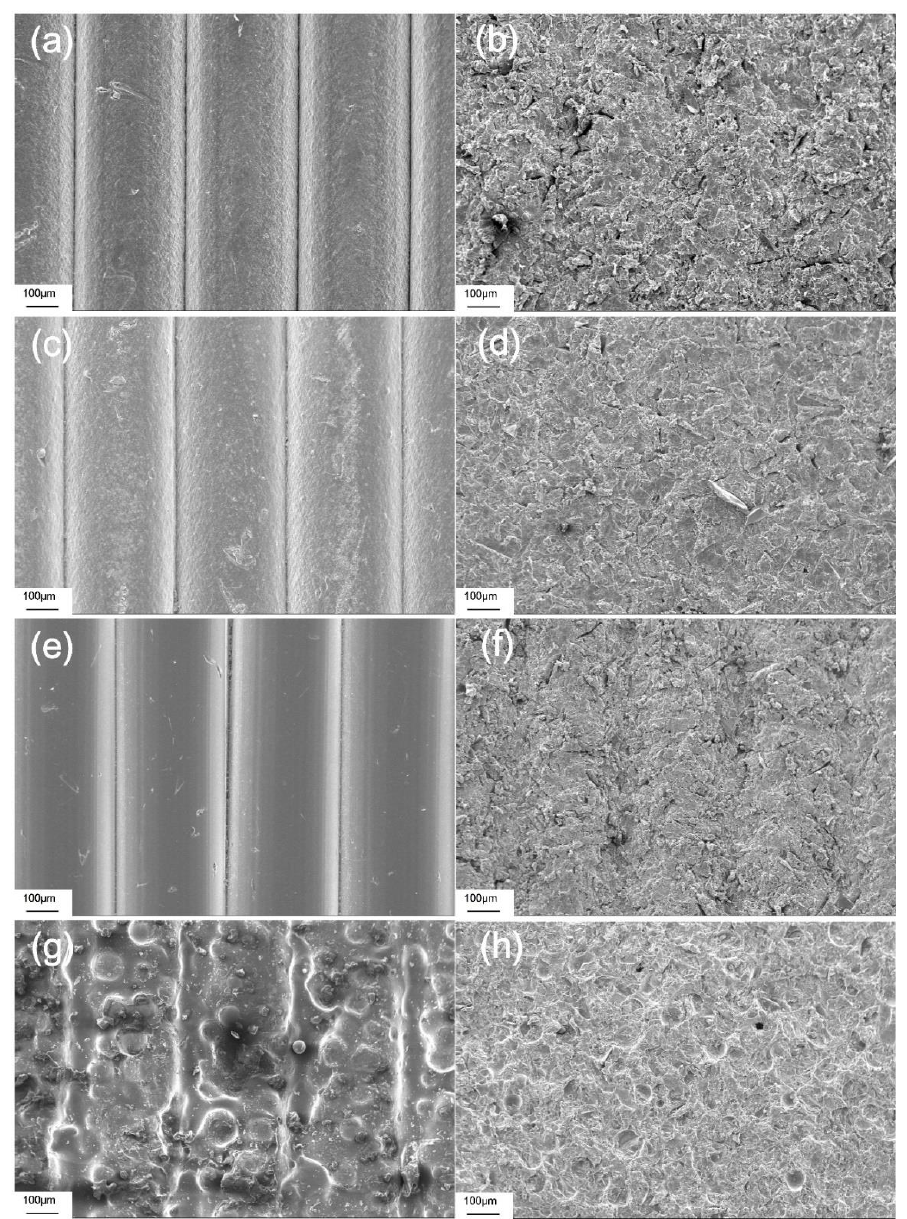
Figure 6. SEM pictures with 200 × magnification. ( a ) ABS before GB; ( b ) ABS after GB; ( c ) HIPS before GB; ( d ) HIPS after GB; ( e ) PETG before GB; ( f ) PETG after GB; ( g ) Reference resin before GB; ( h ) Reference resin after GB.